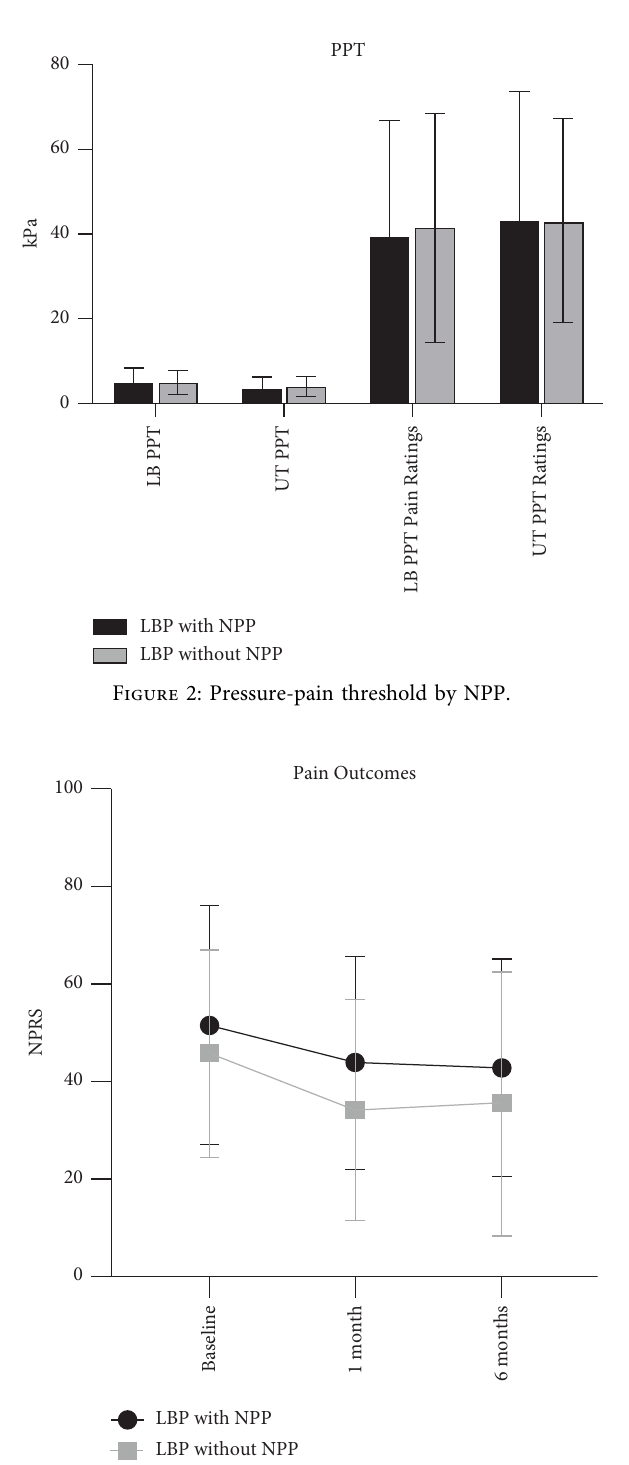
Figure 3: Short- and long-term pain outcomes after physical therapy.